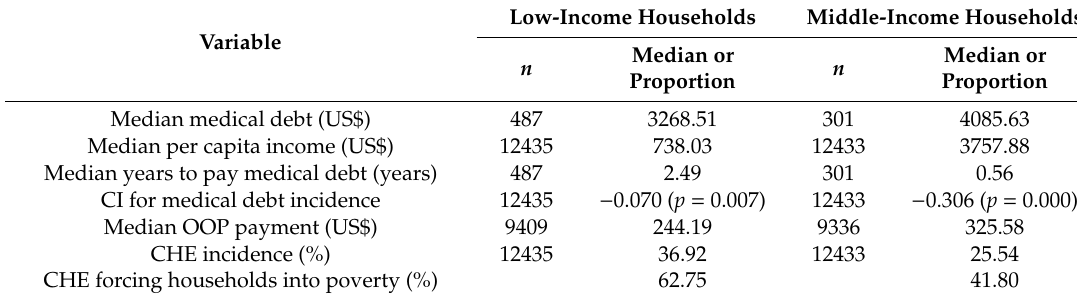
Table 1. Medical Financial Burden of Middle- and Low-Income